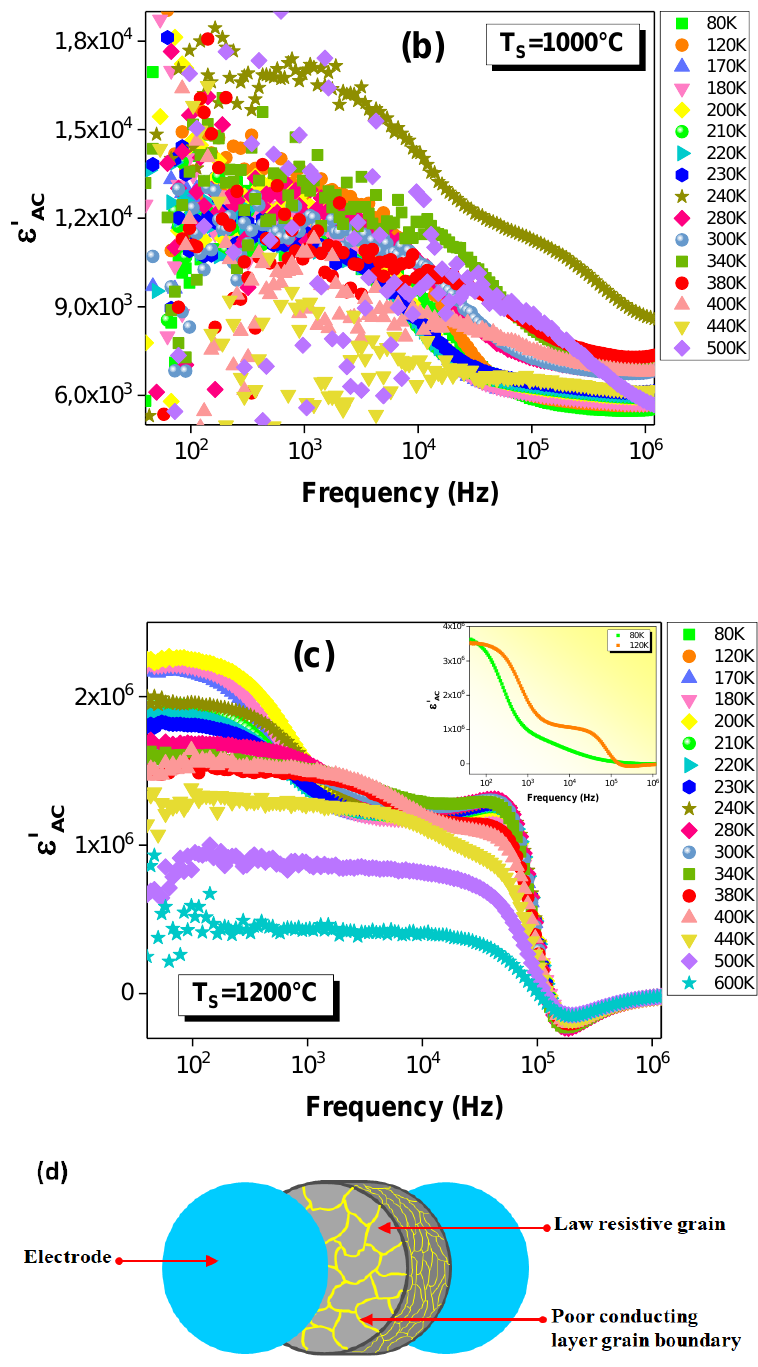
Figure 5. Spectra of the real part of the relative dielectric permittivity ( ε′ ) at different temperatures for the La0.9Sr0.1MnO3 system sintered at ( a ) 800, ( b ) 1000 and ( c ) 1200 °C. ( d ) Schematic representation of the sample structure.